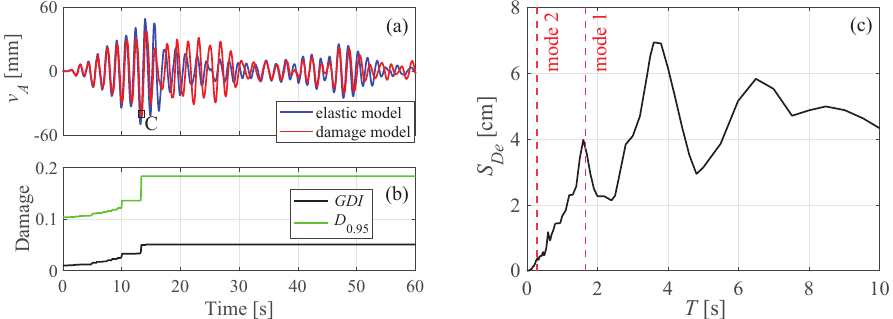
Figure 15. Earthquake ALT station: ( a ) elastic and damage responses of the equivalent pier, ( b ) evolution of the GDI and D 0.95 , ( c ) elastic displacement spectrum.